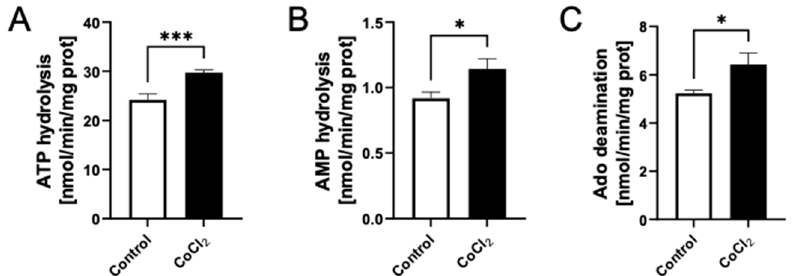
Figure 2. CoCl 2 -mimicked hypoxia promoted extracellular nucleotide hydrolysis and adenosine deamination in H5V endothelial cells. The rates of extracellular ATP hydrolysis ( A ), AMP hydrolysis ( B ), and adenosine (Ado) deamination ( C ) in H5V cells in control and hypoxia-mimic conditions (CoCl 2 ). Results are shown as mean ± SEM; n = 6; * p < 0.05, *** p < 0.01.